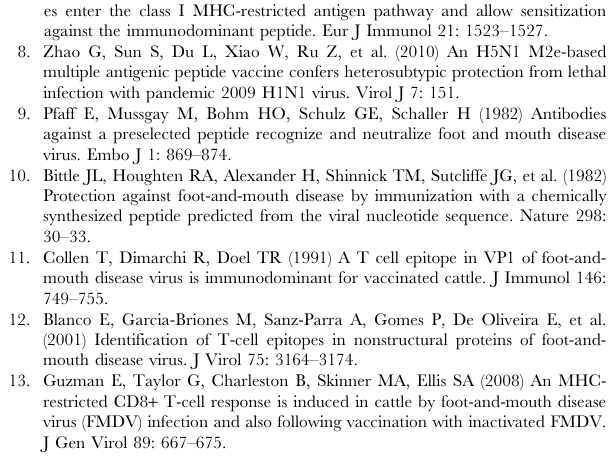
Figure S1 Comparing the cellular immunity responses inducing by liposomes and IFA. Mice in IFA control group